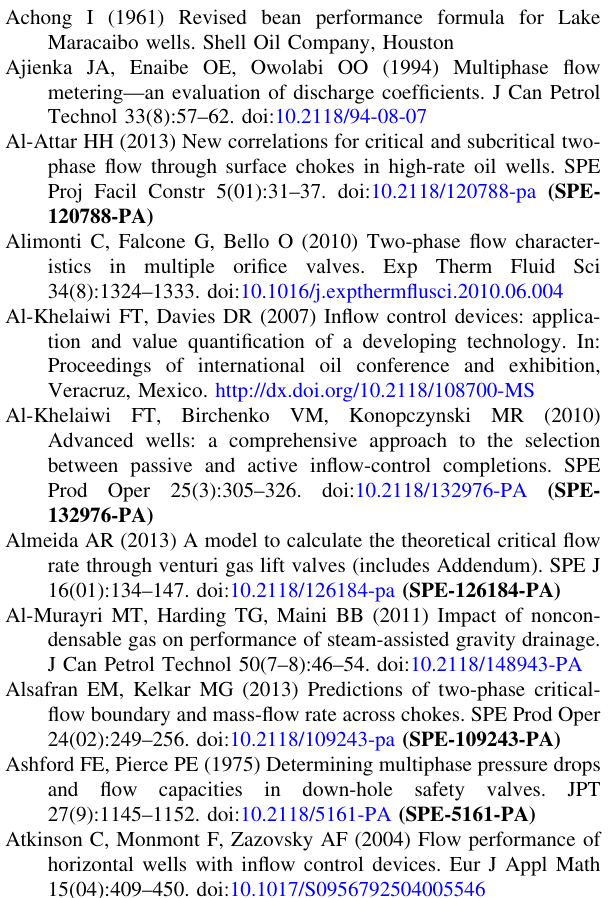
categories for the SAGD application. Table 2 expands upon autonomous FCD subtypes with details again